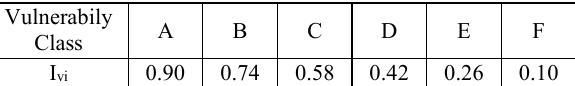
Table 1. Initial vulnerability indices I vi .